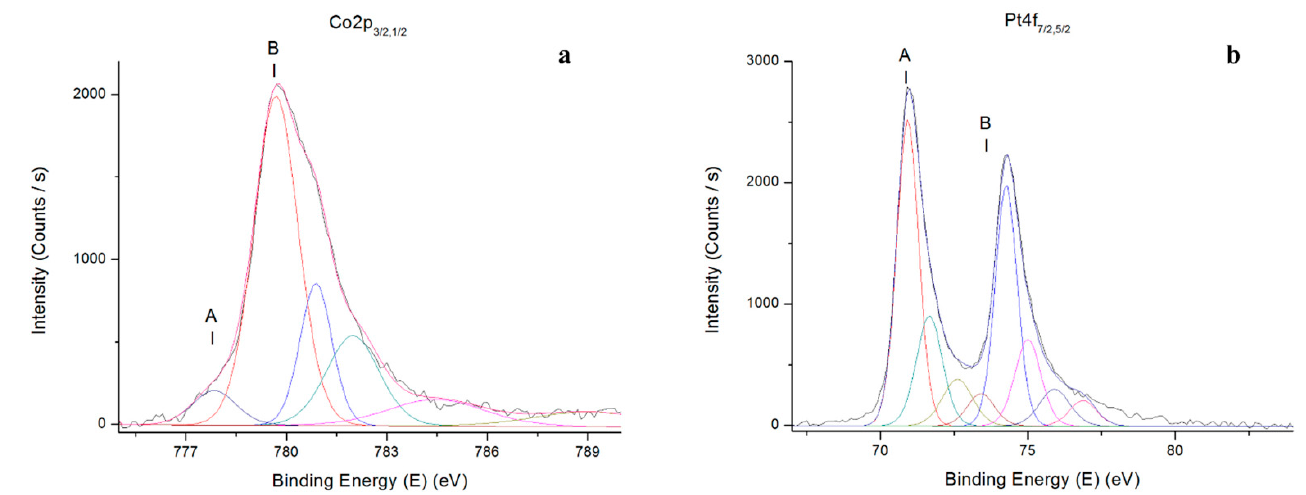
Figure 5. XPS spectra for ( a ) Co2p and ( b ) Pt4f of the PtCo/C catalyst PCC2.